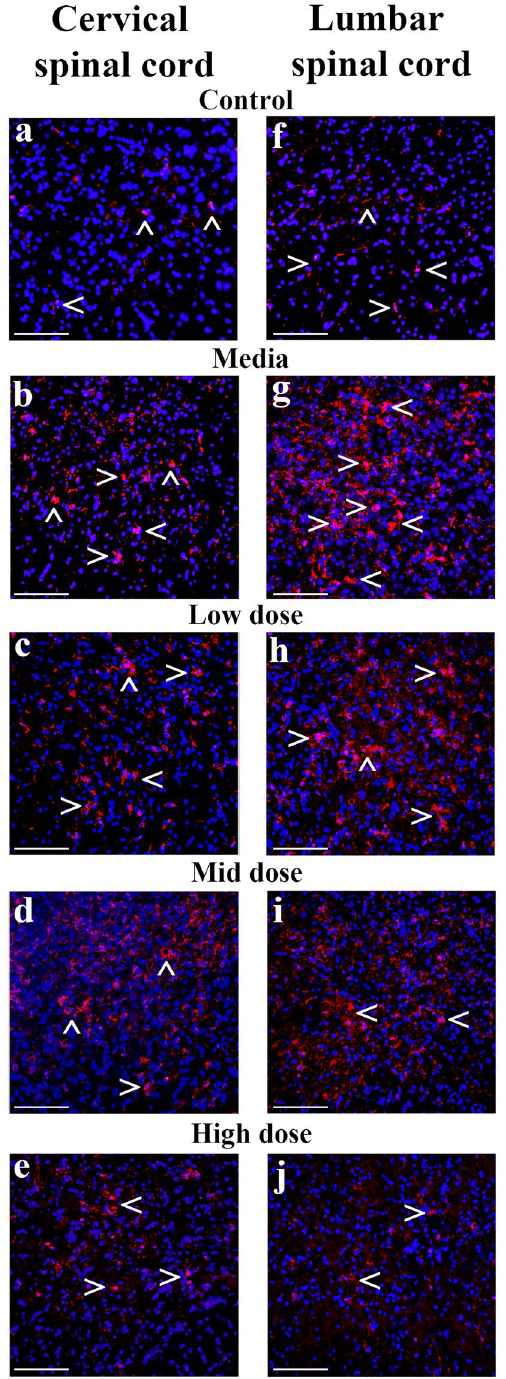
Figure 7. Characteristics of microglial cells in the ventral horn of spinal cords from G93A mice. Immunohistochemical staining of microglia using anti-Iba-1 antibody was performed in the cervical and lumbar spinal cords from cell-treated, media-injected, and control mice at 17 weeks of age. Microglial cells showed typical morphology (red, arrowheads) in the ventral horn of the cervical ( a ) and lumbar ( f ) spinal cords of control mice. Substantial cervical ( b ) and lumbar ( g ) microgliosis was noted in media-treated animals. Morphologically, numerous activated microglial cell with large cellular bodies and short processes were observed (arrowheads). Microglial cell activation was decreased in the cervical and lumbar ventral horns of ALS mice treated with low ( c , h ), mid ( d , i ), or high ( e , j ) cell doses. In cell-treated animals, many microglial cells with smaller cell bodies and fine cell processes (arrowheads) at a low density of Iba-1 immunoexpression were detected. Ramified microglia were mostly observed in the cervical and lumbar spinal cords of mice receiving the high cell dose. Scale bar in ( a – j ) is 100 µ